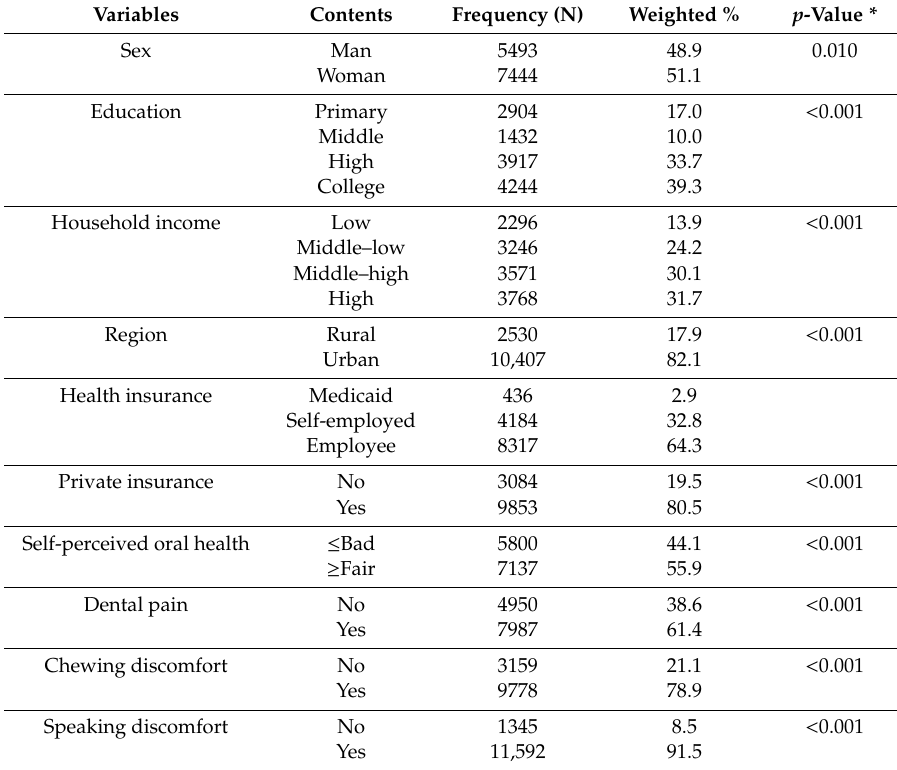
Table 1. Distribution of study participants by